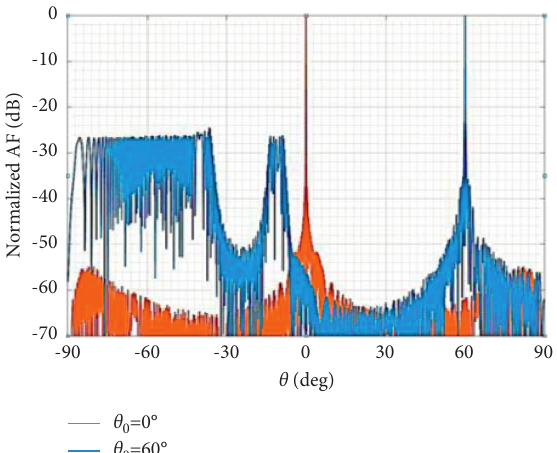
Figure 13: Normalized AF patterns featured by an isophoric 2000-element sparse linear array with antenna separation d angles of 0 and 60 degrees [60]. The array was synthesized with no constraint on the overall length, which, eventually, was extended up to 1344.2 λ